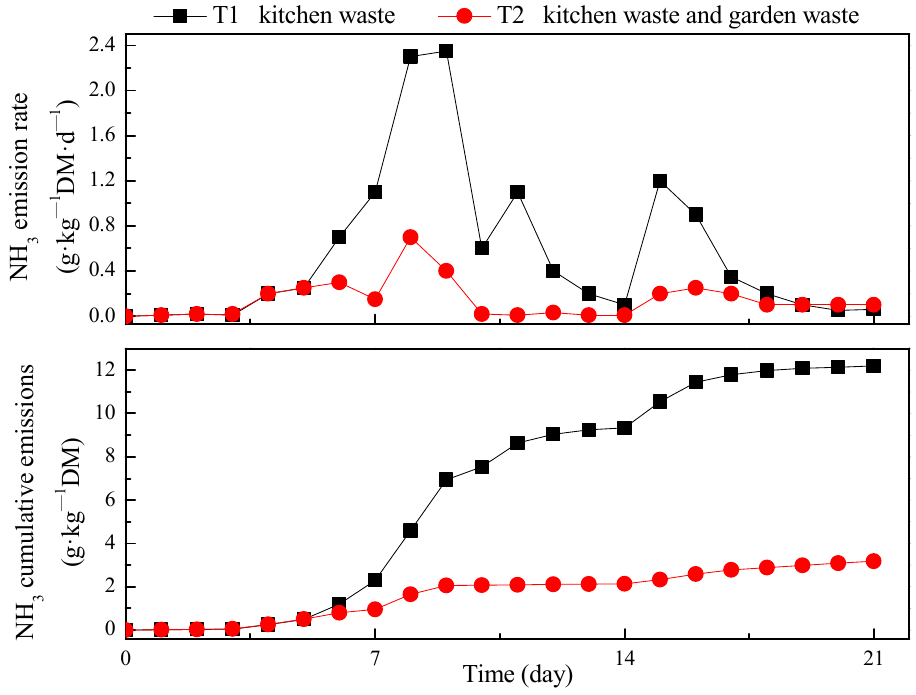
Figure 5. Evolution of NH 3 during composting.